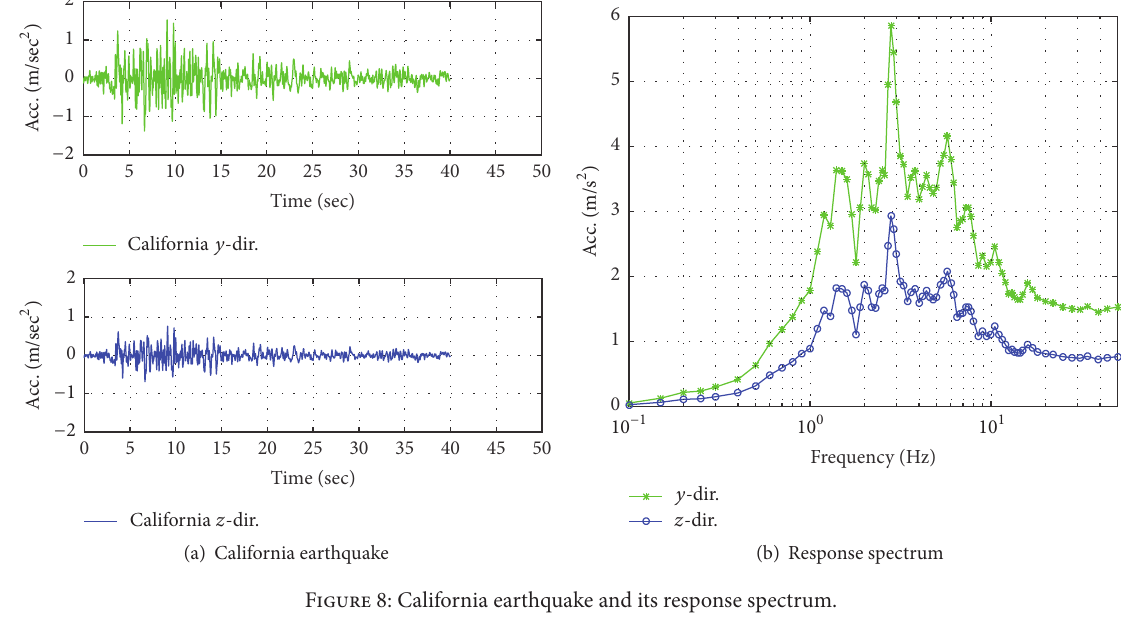
Figure 8: California earthquake and its response spectrum.